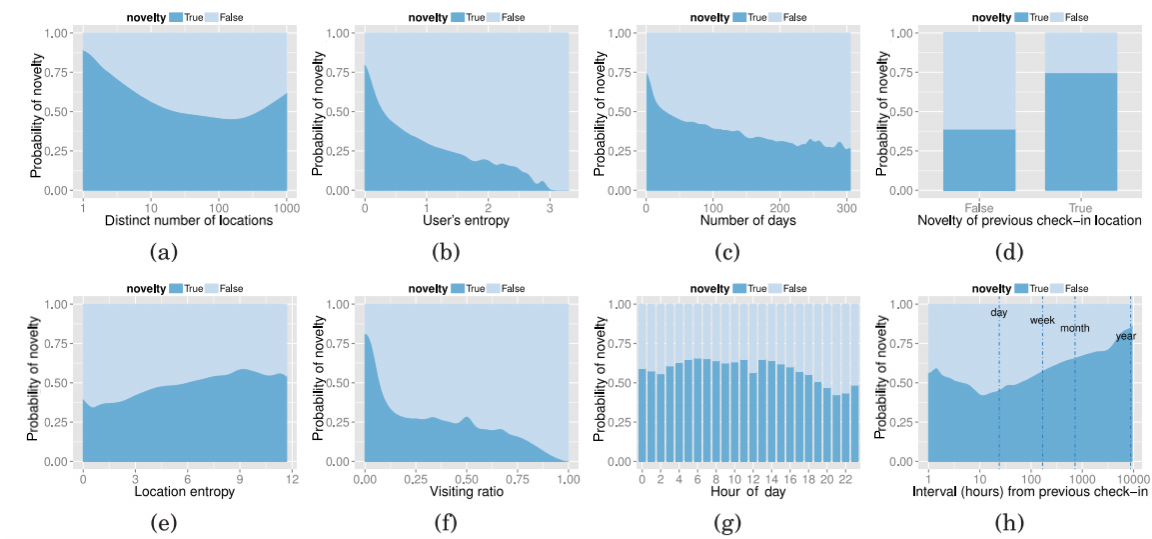
Fig. 4 Influence of different features on novel check-in location behaviours, x -axes are features and y -axes are the conditional probabilities. (a) Distinct number of locations, (b) user entropy, (c) number of days, (d) novelty of check-in location, (e) location entropy, (f) visiting ratio, (g) hour of day, and (h) interval since previous check-in [48]